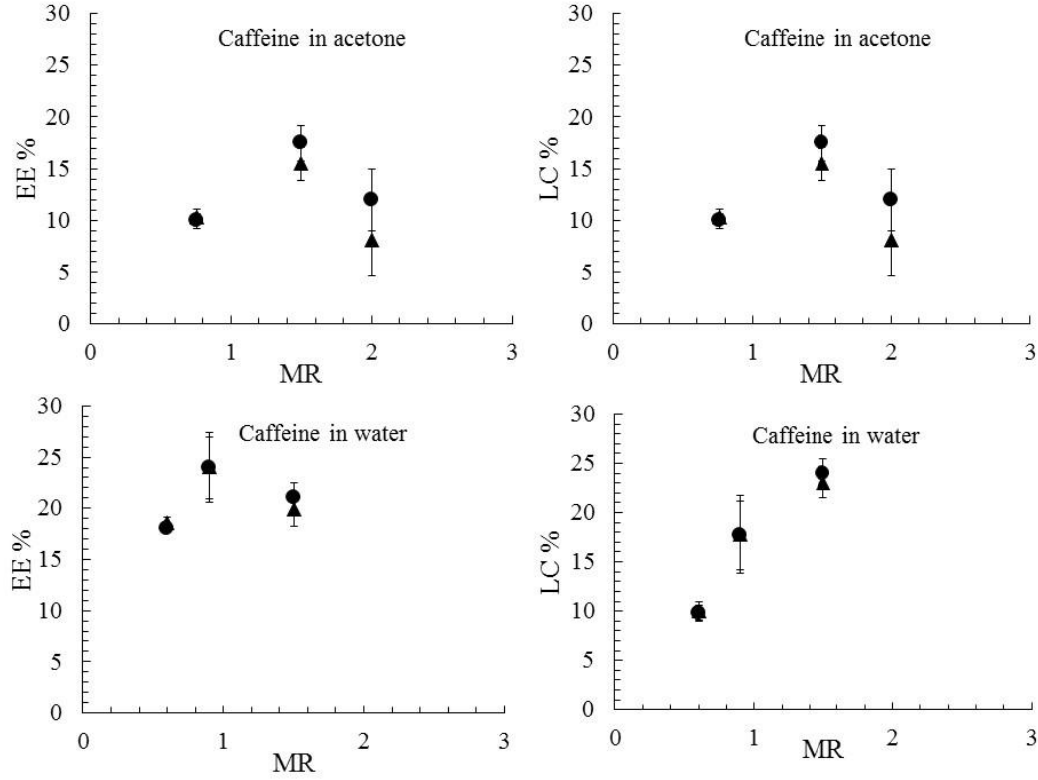
Figure 7. LC and EE as a function of MR for samples produced with caffeine in acetone (top) and caffeine in water (bottom). Results obtained with direct ( ▲ ) and indirect ( ⚫ ) protocols. All samples produced at FR = 20 mL/min.